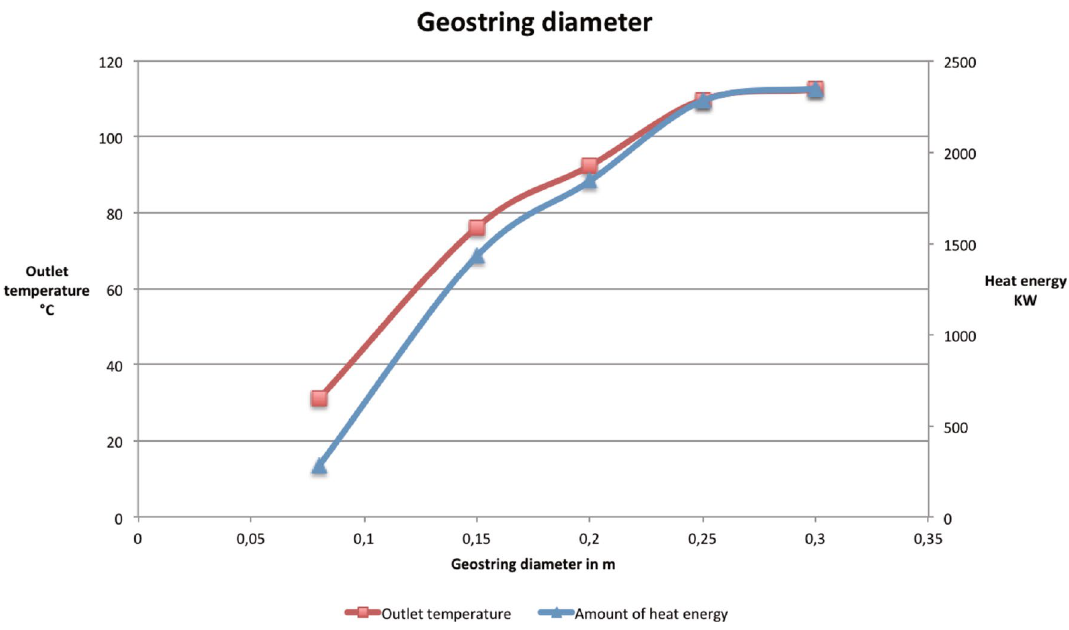
Fig. 8 Temperature and heat energy regarding diameter of the